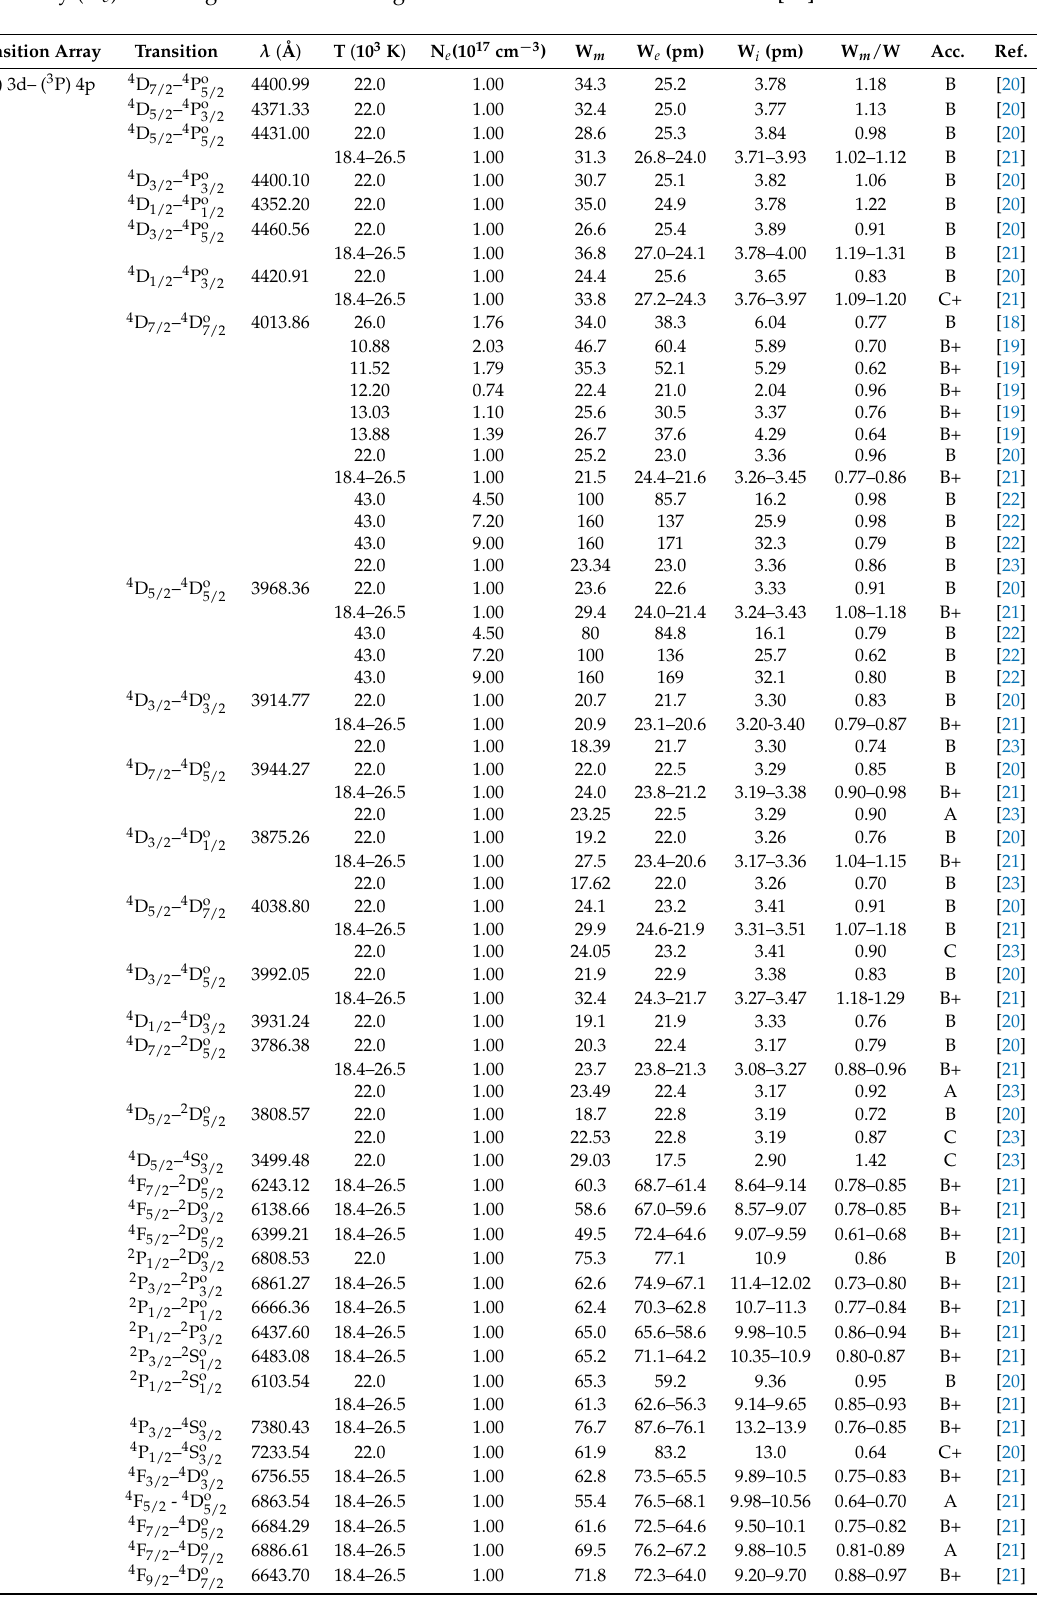
Table 1. Our electron impact Stark widths (FWHM) (W e ) and ion impact Stark width (W i ) calculated using the semiclassical perturbation (SCP) approach in impact approximation [14,15] compared with experimental Stark widths (W m ). Transitions, wavelengths, electron temperature (T) and electron density (N e ) are also given. All wavelengths are taken from the NIST database